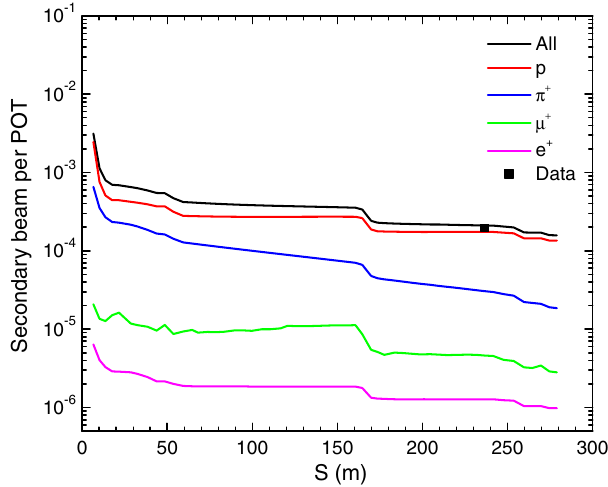
FIG. 6. Simulated performance of secondaries along the Muon Campus M2 and M3 lines for the baseline design specifications. The overall number of secondaries is scaled to the POT, and only particles within − 52 mm < x or y < 52 mm are recorded. The black square shows the measured beam intensity at IC 740. Notice that the lattice is designed to have a narrow momentum acceptance of Δ p=p ¼ (cid:2) 4 %.